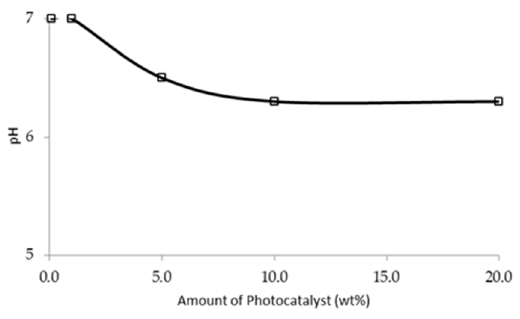
Figure 7. Surface charge of the photocatalyst 0.2Fe-TiO 2 /AC.